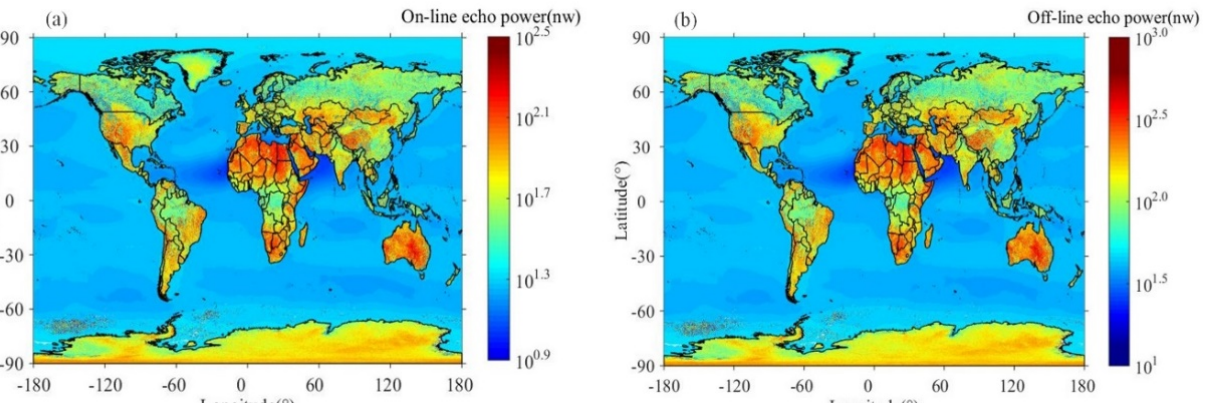
Figure 4. ( a ) Global online echo power. ( b ) Global offline echo power.